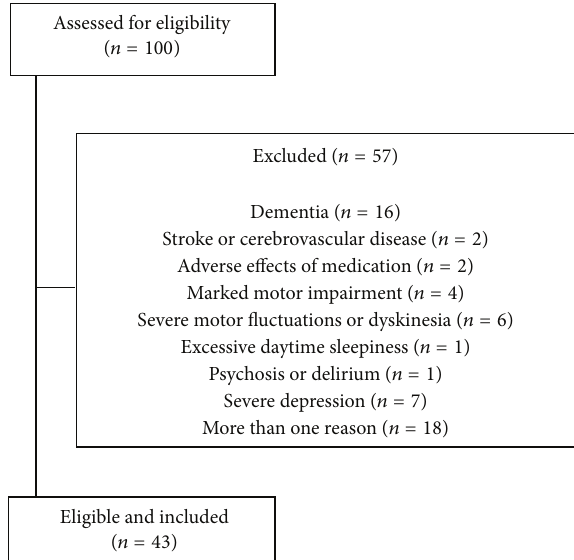
Figure 1: Flow diagram of the study and reasons for patients’